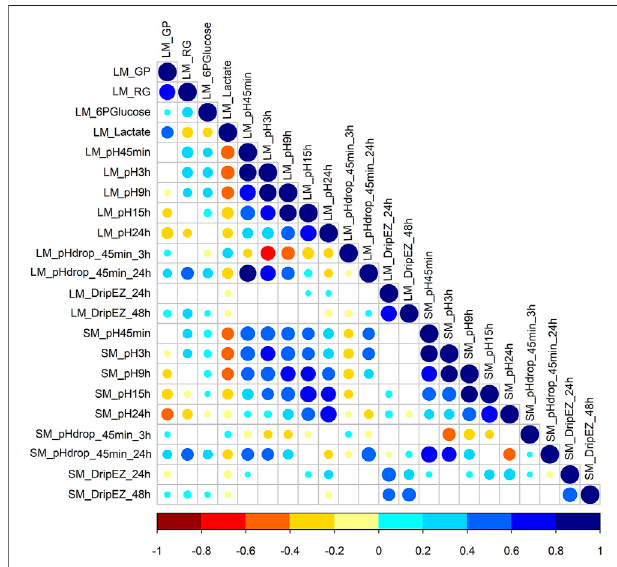
FIGURE 1 | The Pearson correlation coef fi cients for each pair among 22 meat quality traits. The blue and red colors represent positive and negative direction of the correlation coef fi cient. A correlation coef fi cient of < − 0.16 or > 0.16 indicates a signi fi cant threshold of p <